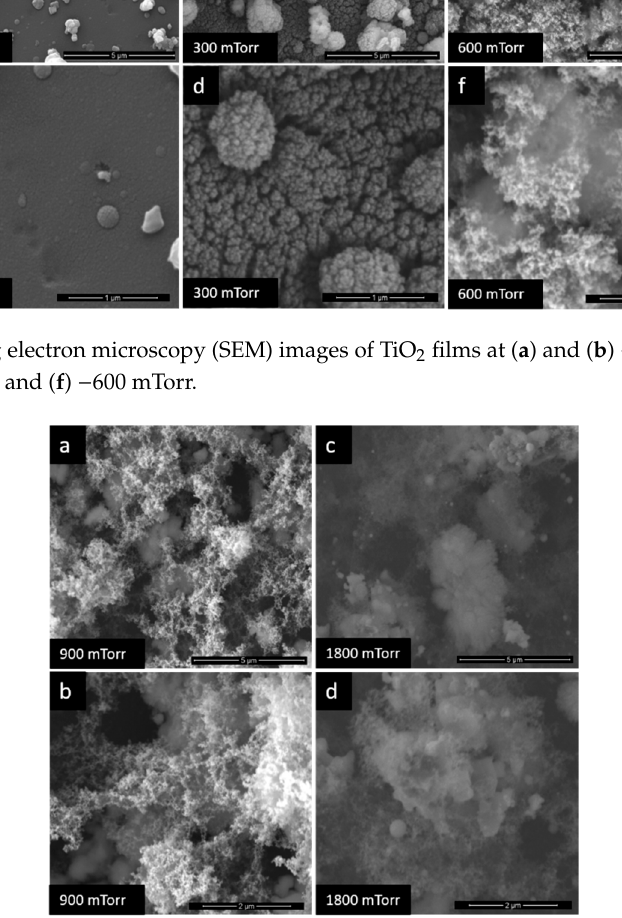
Figure 3. SEM images of TiO 2 films at ( a ) and ( b ) − 900 mTorr, ( c ) and ( d ) − 1800 mTorr.